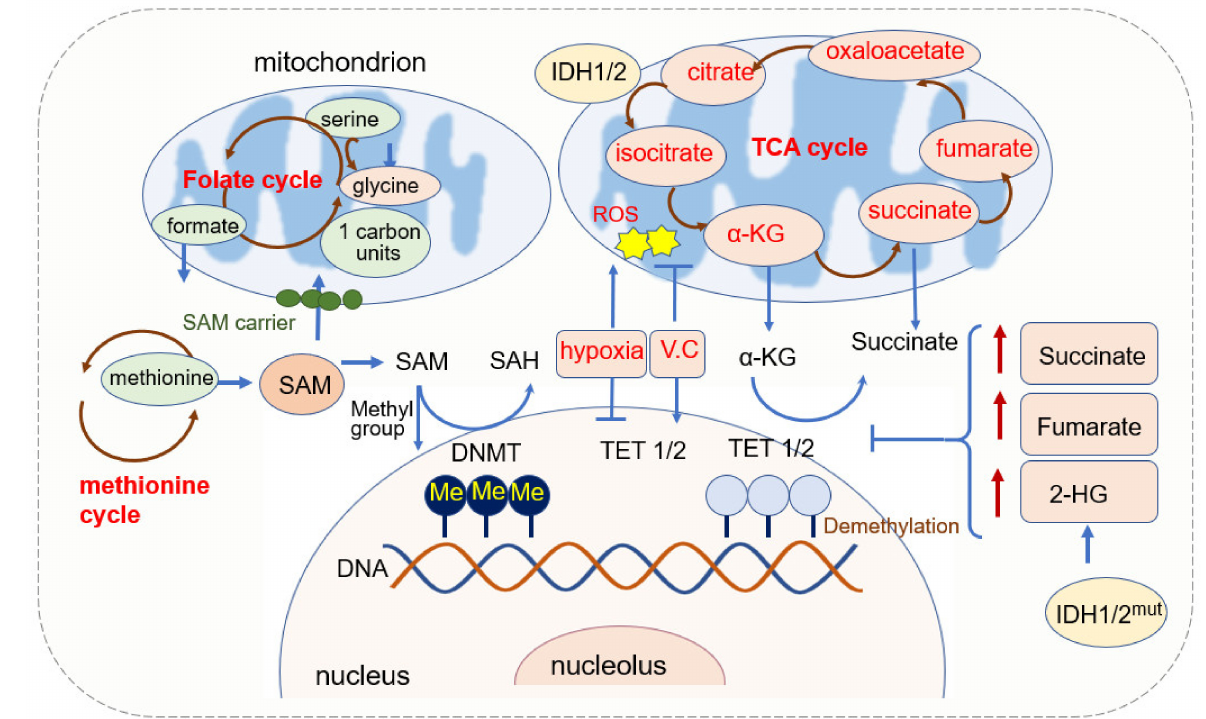
Figure 1. Mitochondrial function in DNA